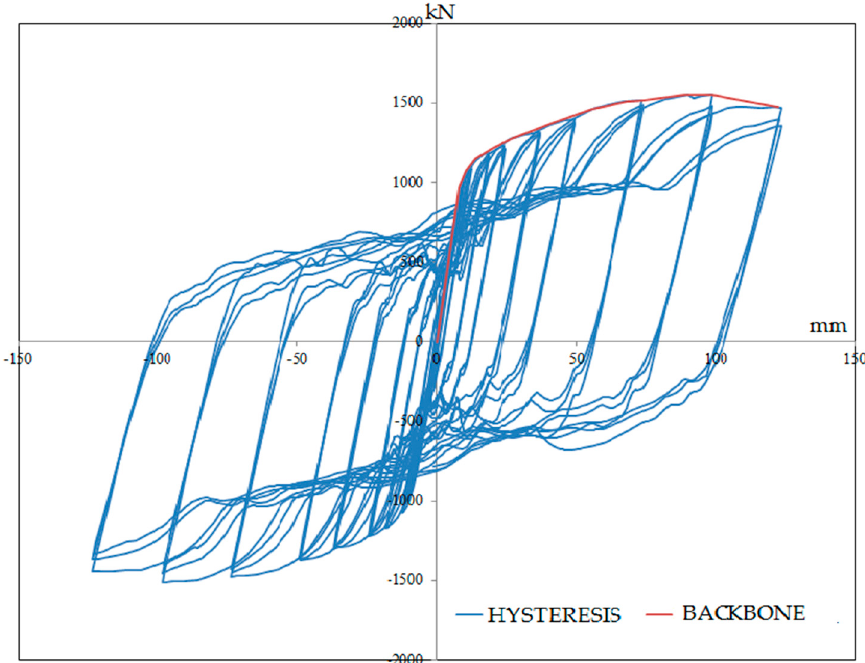
Figure 4. Hysteresis and extracted backbone graph of FE model.